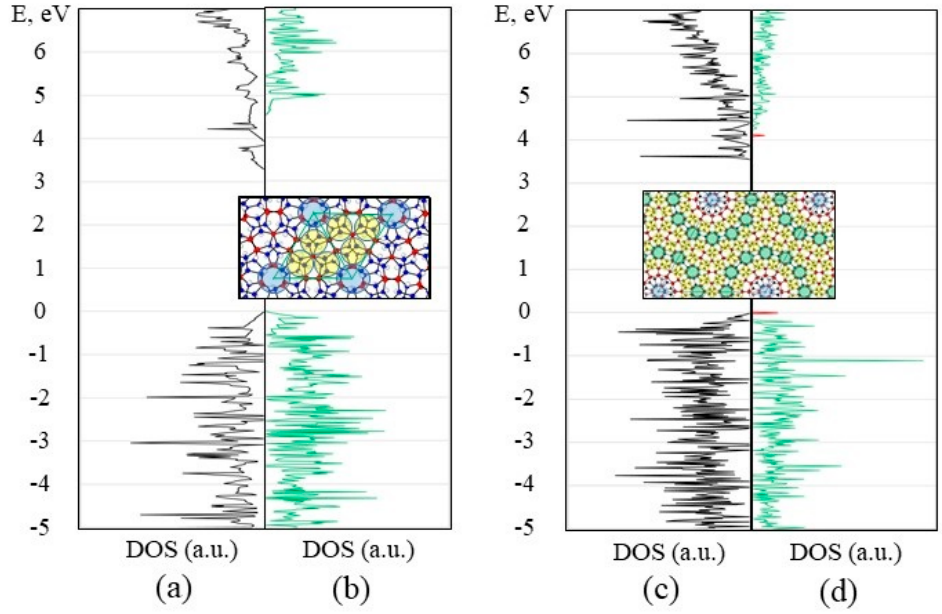
Figure 16. Density of electronic energy states (DOS) for Dn27.8 ( a ) and F-Dn27.8 ( b ) diamanes, with bandgaps of 3.3 and 4.5 eV, and Dn29.4 ( c ) and F-Dn29.4 ( d ) diamanes, with bandgaps of 3.6 and 4.1 eV, respectively. Insets—relevant structures with unit cell rhombuses [44].